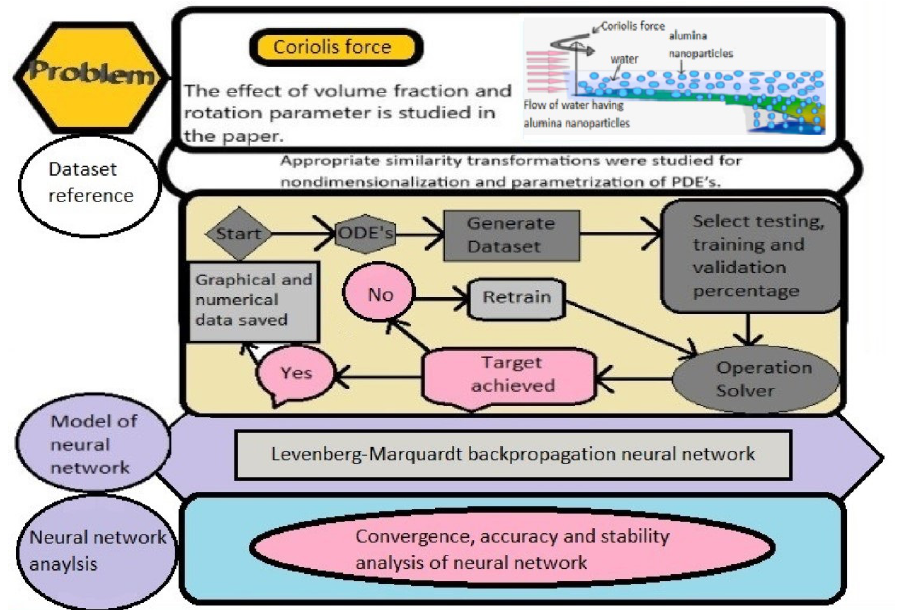
Figure 4. Flow chart of the proposed